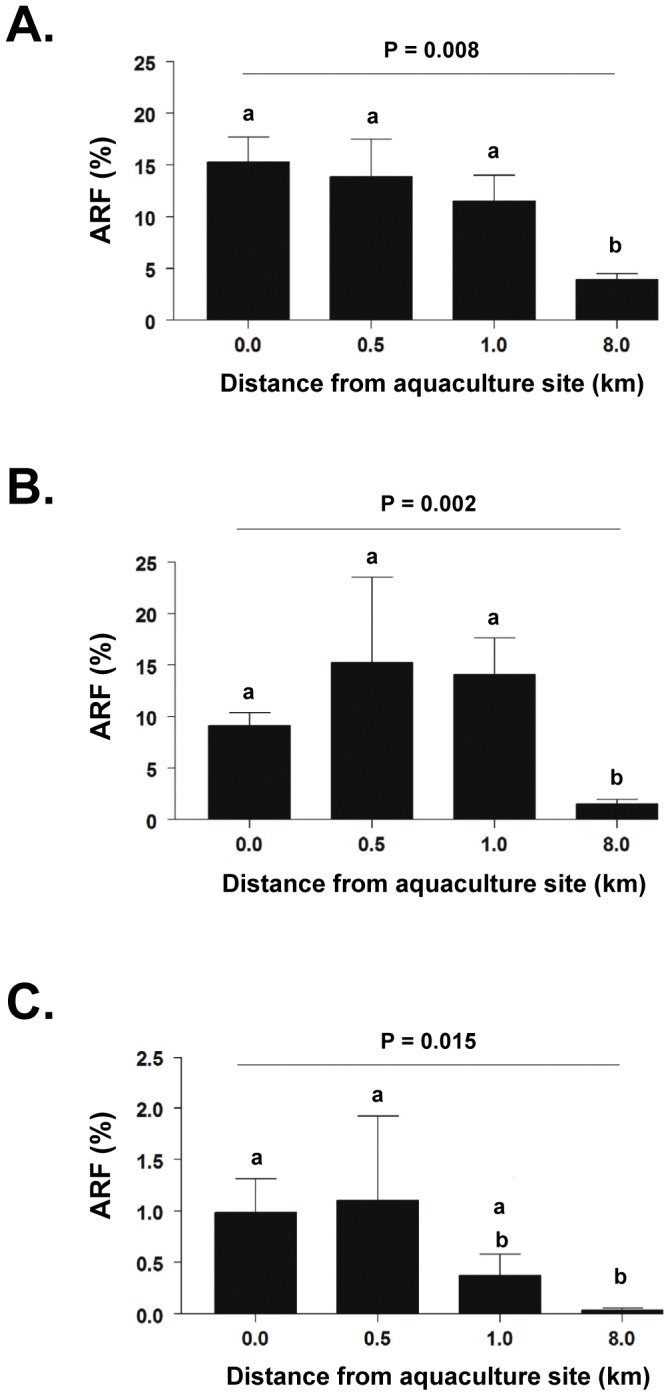
Variation in ARF to selected antimicrobials with distance from aquaculture site.ARF (mean ± SE) in November, 2008, to (A) oxytetracycline, (B) oxolinic acid, and (C) florfenicol in sediments at aquaculture site (0.0 km) and at sites 0.5, 1.0 and 8.0 km (control site) distant from it. ARF for aquaculture and control sites correspond to ARF shown in Fig. 3 for this date. Five samples were taken from each additional site studied. ARF to each antimicrobial were significantly greater at the aquaculture than at the control site (probabilities indicated for each antimicrobial). Different lower case letters within each panel indicate significant differences between ARF (P<0.05, see text for details of statistical analysis).